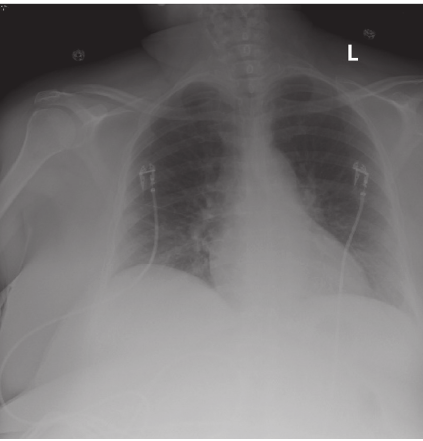
Figure 1: Normal radiograph without evidence of acute intra- thoracic